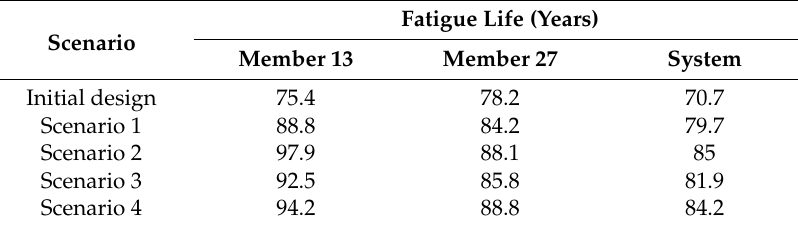
Table 4. Fatigue lives for inequality cases (Scenarios 1–4 in Table 3).